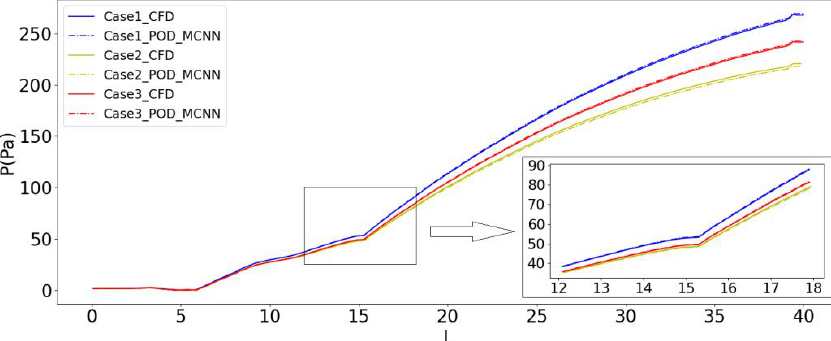
Figure 13. Pressure trend prediction results for three cases on test data. After training, the model performs well on the temperature and pressure field pre- diction tasks of the test data, and can predict the flow field data of the test set accurately.